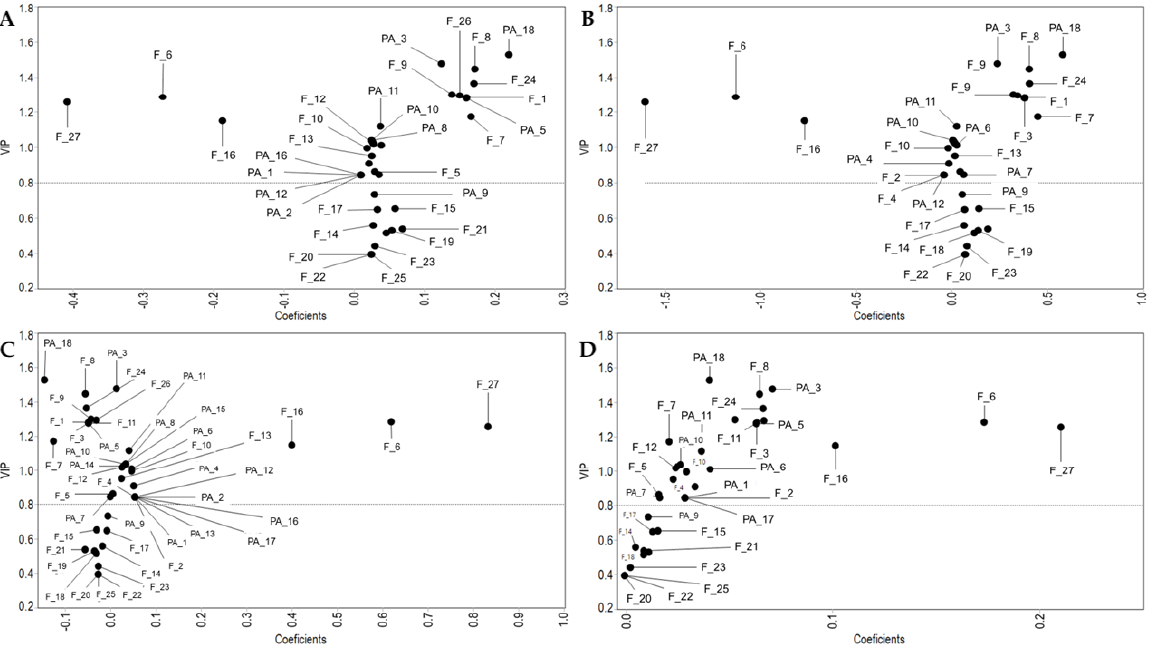
Figure 2. Association of polyphenols of S. macrodontus extracts and microbial growth. ( A ) V. para- haemolyticus, ( B ) V. harveyi , ( C ) P. damselae, and ( D ) P. leiognanathi .